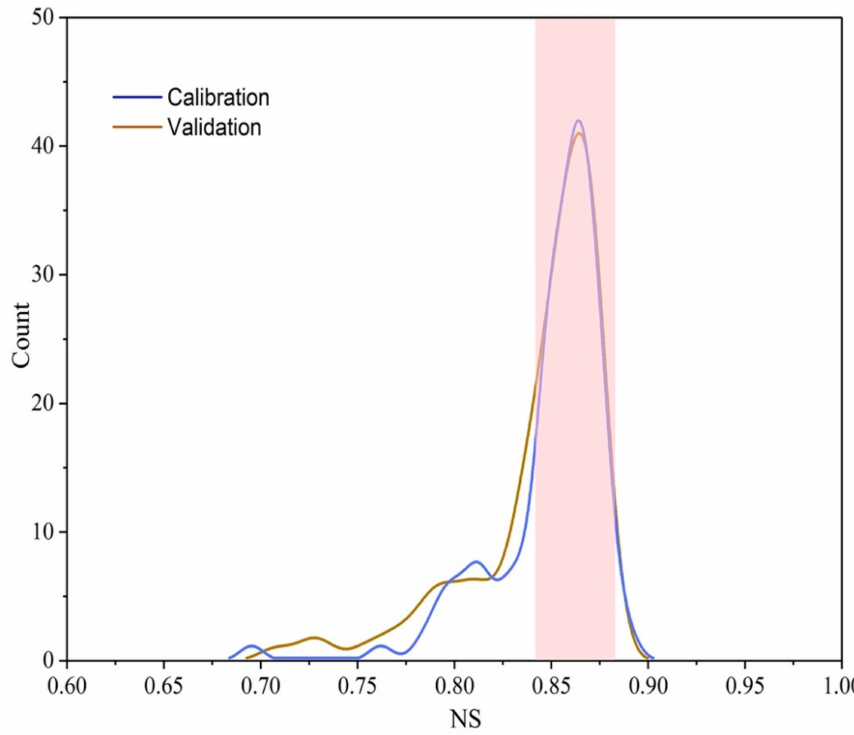
Figure 6. Kernel smoothing fit of the distribution of